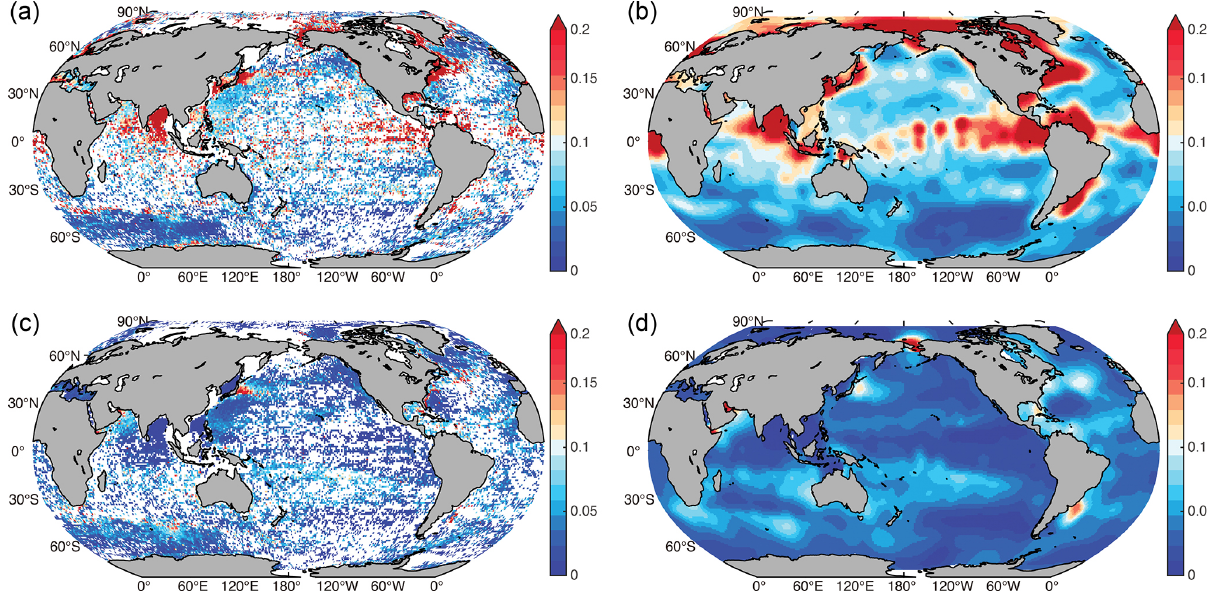
Figure 2. The estimated Var (a quantification of salinity subgrid variability) of in situ observations in this study. The original (a, c) and objectively analyzed fields (b, d) are presented for the depths of 20m (a, b) and 300m (c, d) , respectively, as two